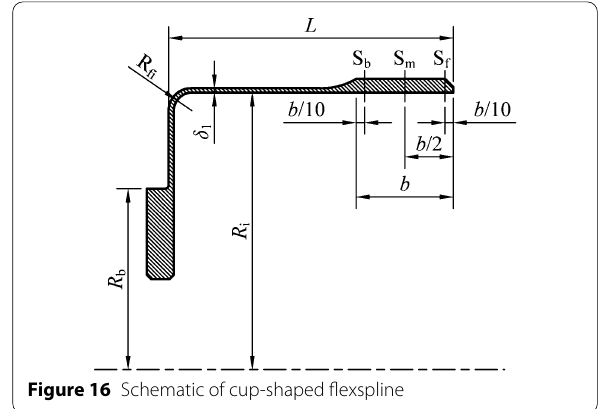
Figure 16 Schematic of cup-shaped